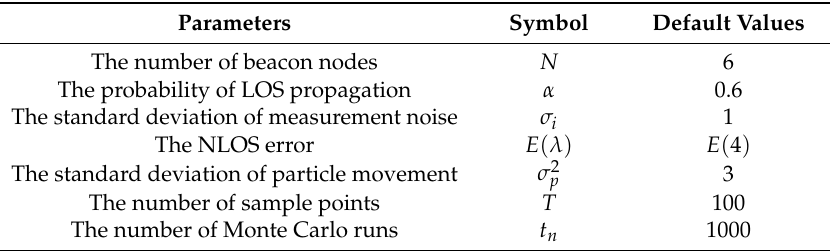
Table 4. The default parameter values.